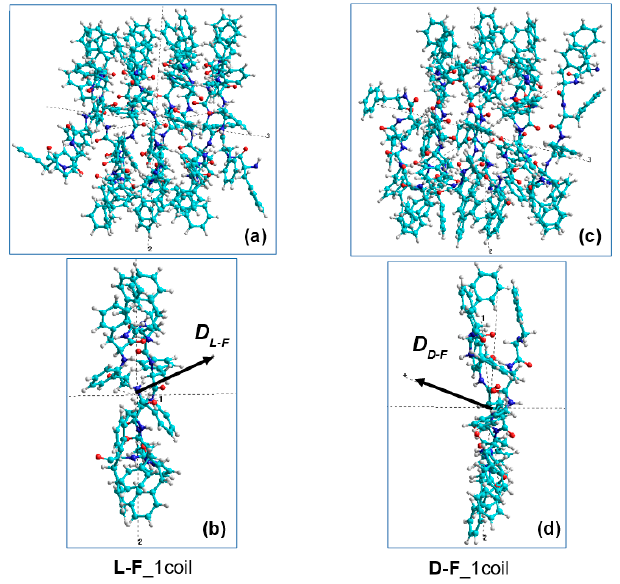
Figure 8. Selection of the one coil from the four in PNT helix-like structures (in X-projection): ( a ) and ( b )–for the L-F PNT; ( c ) and ( d )–for the D-F PNT.